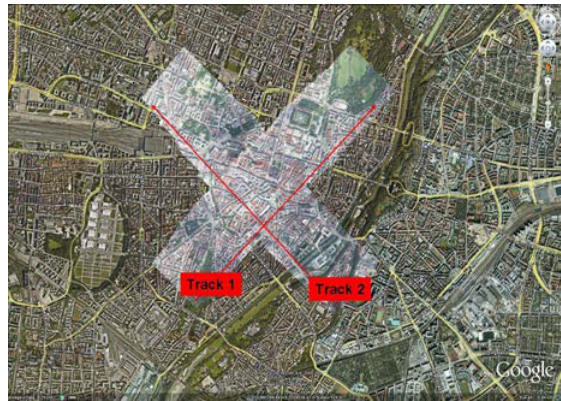
Figure 3. Mosaics produced with two airborne 3K-image scenes gathered over Munich city, overlaid over Google earth ® .